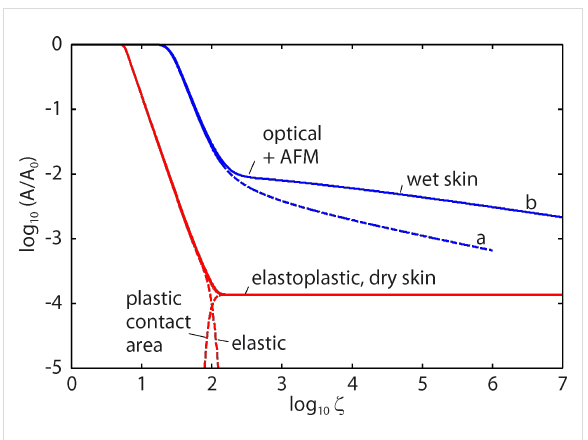
Figure 8: The ratio of the contact area A to the area of the nominal contact area A 0 as a function of the lower scale magnification ζ included in the calculation in a log 10 –log 10 scale. The blue and the red curves correspond to wet and dry skin. The solid and dashed blue curves use the surface power spectra denoted by b (optical and AFM data pooled together) and a (optical data only) in Figure 5, respective- ly. The skin model shown in Figure 6 is used in the calculations. The squeezing pressure was assumed as F N / A 0 = p 0 = 6.83